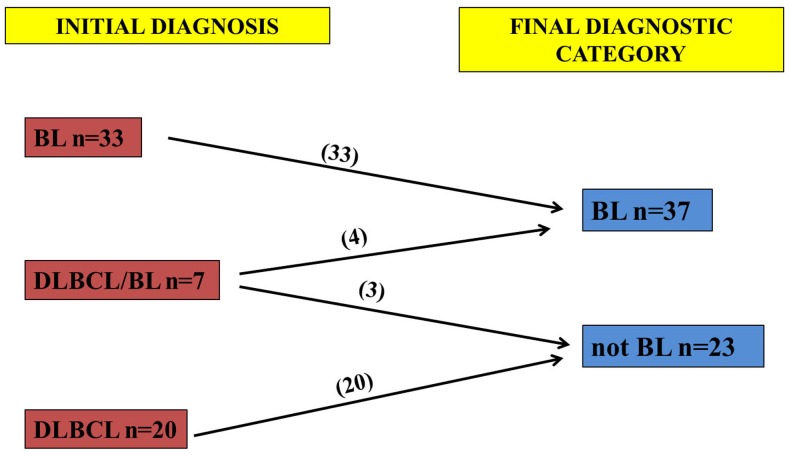
Classification of cases according to the algorithm proposed by Naresh et al.After the revision of 43 BL, 30 DLBCL and 7 DLBCL/BL cases, 47 BL and 33 not-BL cases were identified.